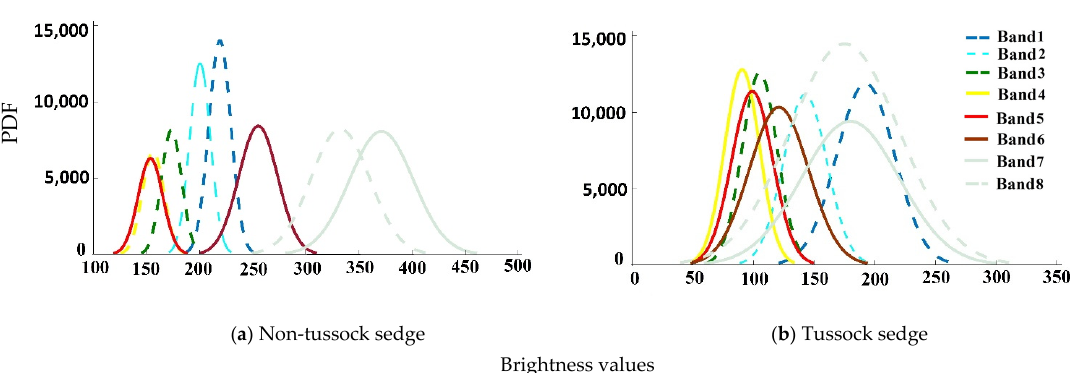
Figure 4. Probability distribution function for the multispectral band datasets.